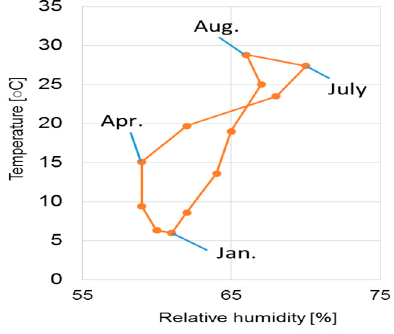
Figure 5. Climate of Osaka [15].